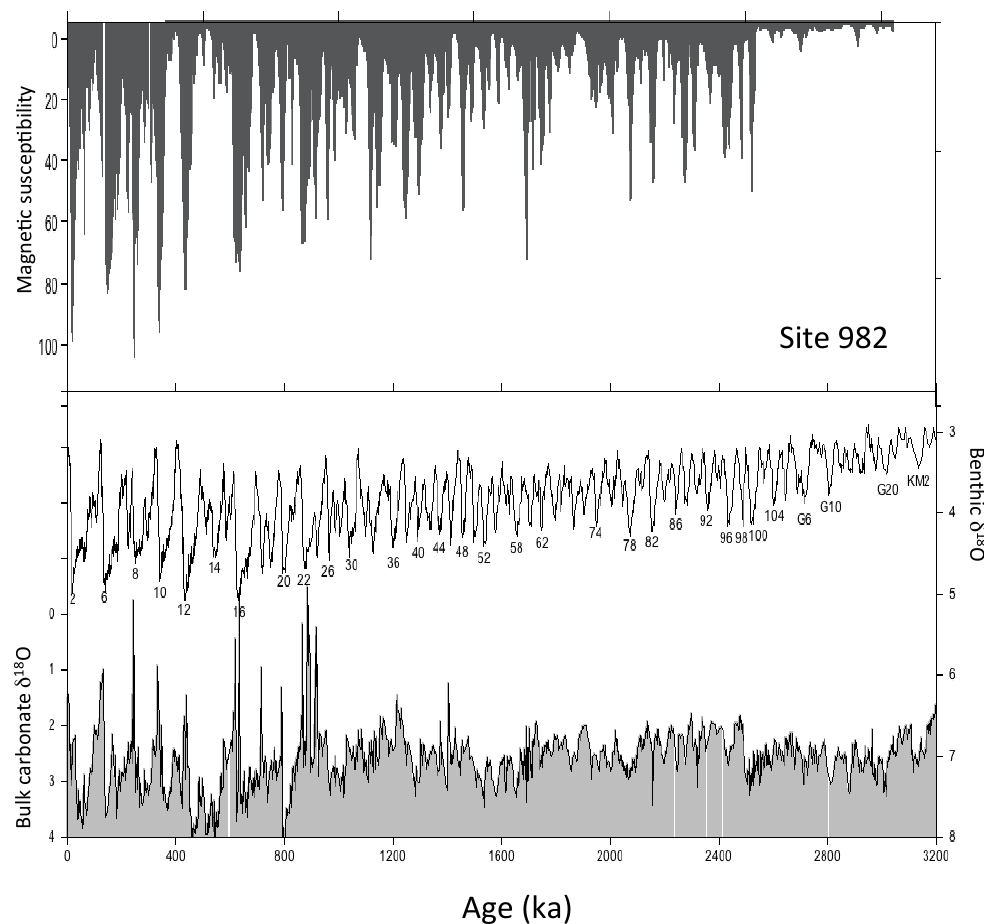
Figure 12. Bulk carbonate δ 18 O (lower) and magnetic susceptibility (upper) at Site 982 compared to the LR04 benthic δ 18 O record (middle; Lisiecki and Raymo, 2005). Note the large millennial decreases in bulk carbonate δ 18 O beginning in MIS 22–24 at